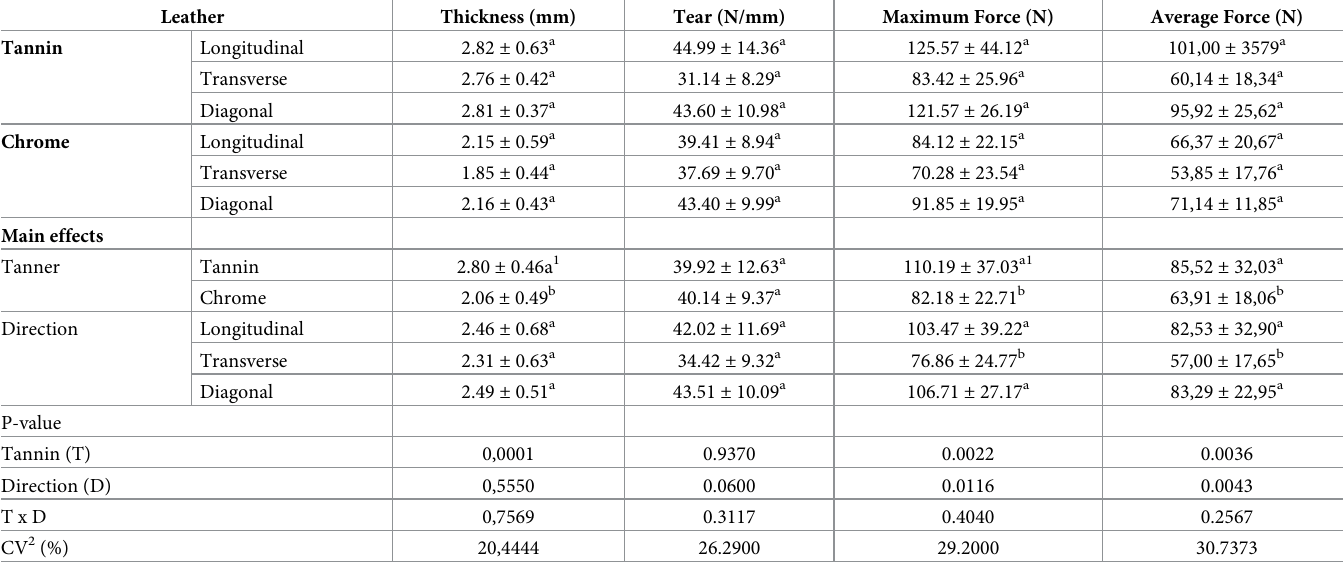
Table 3. Determination of progressive tearing of the paiche ( A . gigas ) leathers tanned with vegetable tannin and chromium salts in longitudinal, transversal and diagonal directions.